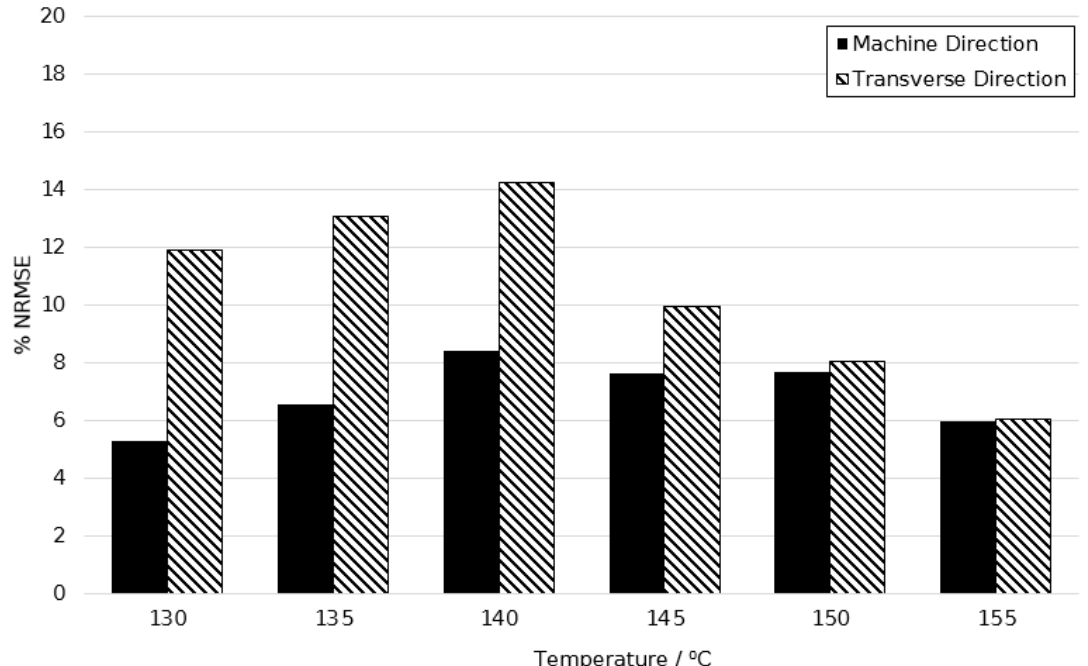
Figure 20. Normalised root mean squared error between simulated and experimentally observed stress–strain behaviour between temperatures of 130 and 155 °C, at a strain rate of 1 s − 1 .